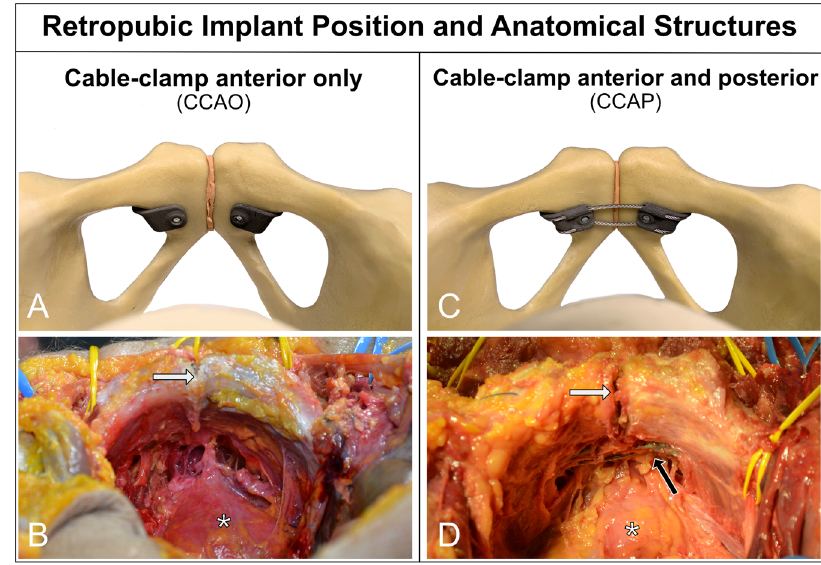
Fig. 7 Retropubic implant position. A slim implant design is desirable to avoid soft tissue irritation, especially in the retropubic space where only a slim soft tissue layer covers the implant and protects the bladder. Images show the position of the implant at the posterior border of the pubic bone that faces the bladder. A The CCAO device attached to a synthetic bone model. B The CCAO device implanted in a cadaver, where the implant is fully covered by soft tissue. C The CCAP device attached to a synthetic bone model, showing the cable than can run in a single or double loop (shown) around the pubic symphysis. D The CCAP device in a cadaver, showing the cable gleaming through the soft tissue in the space of Retzius (black arrow). In panels ( B and D ), the white arrow points towards the pubic symphysis and the asterisk marks the bladder.